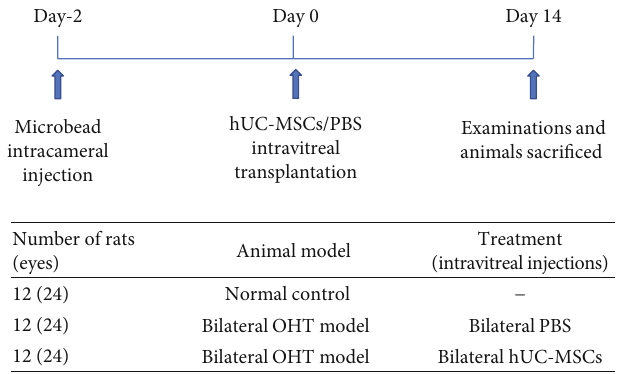
Figure 1: Experimental design. Time schedule of the experimental design detailing the times when the OHT model, intravitreal treatments, and tissue collections were